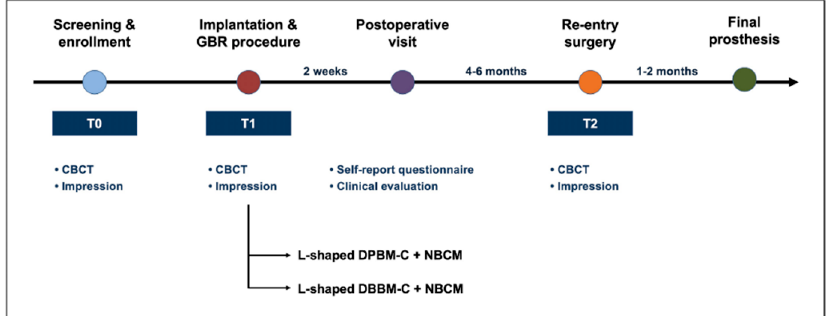
Figure 1. Schematic presentation of the treatment protocol and time points. CBCT sagittal cone-beam computed tomography; DBBM-C, demineralized bovine bone mineral with 10% collagen; DPBM-C, demineralized porcine bone mineral with 10% collagen; GBR, guided bone regeneration; NBCM, absorbable native bilayer collagen membrane.